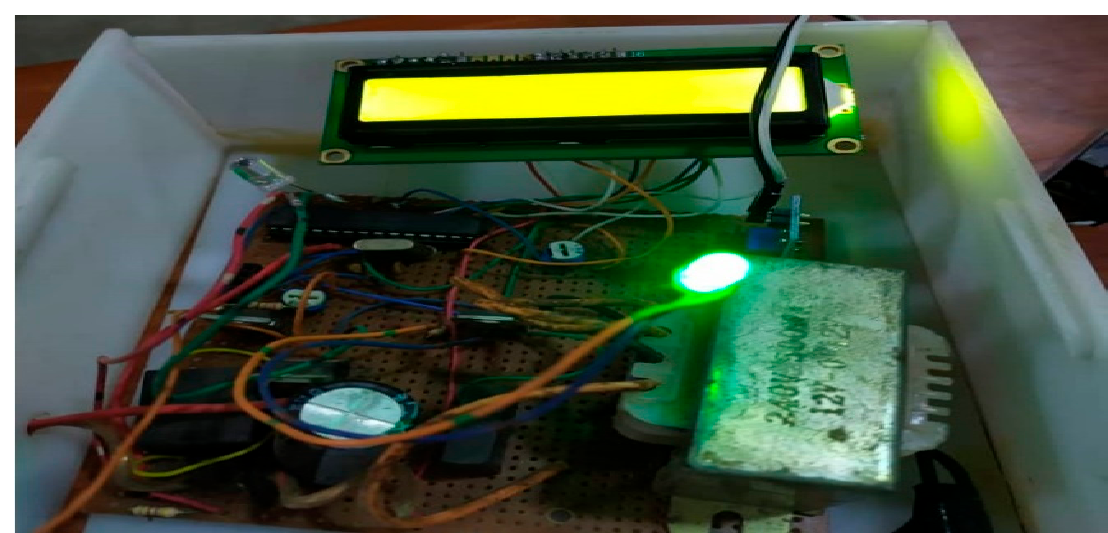
Figure 12. The implemented prototype view part 2.